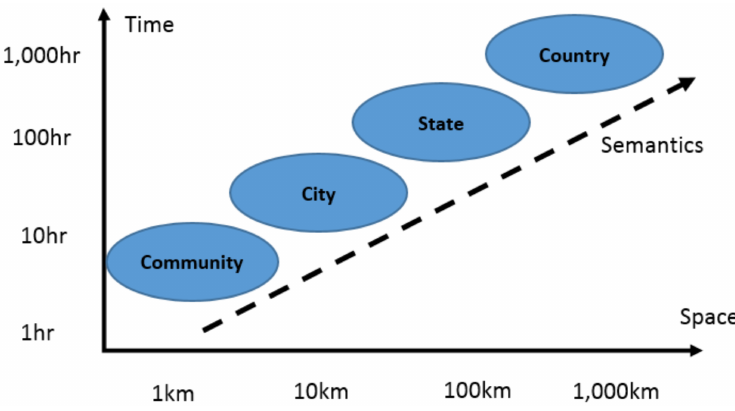
Figure 1. Dimensions and scales in event